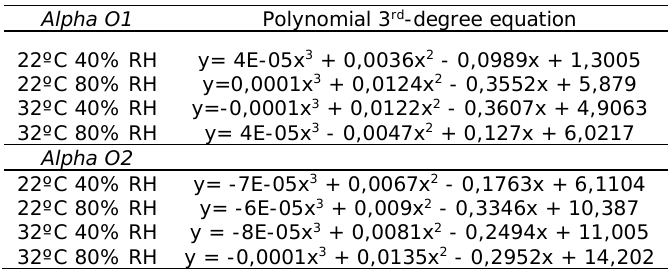
Table 2. Polynomial 3rd degree fitted models (Alpha O1 waves and Alpha O2 waves)